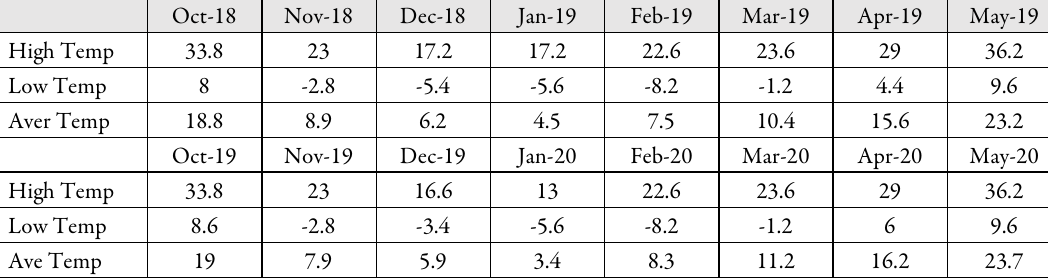
Table 2. The average annual temperature during the years 2018 and 2019 of study